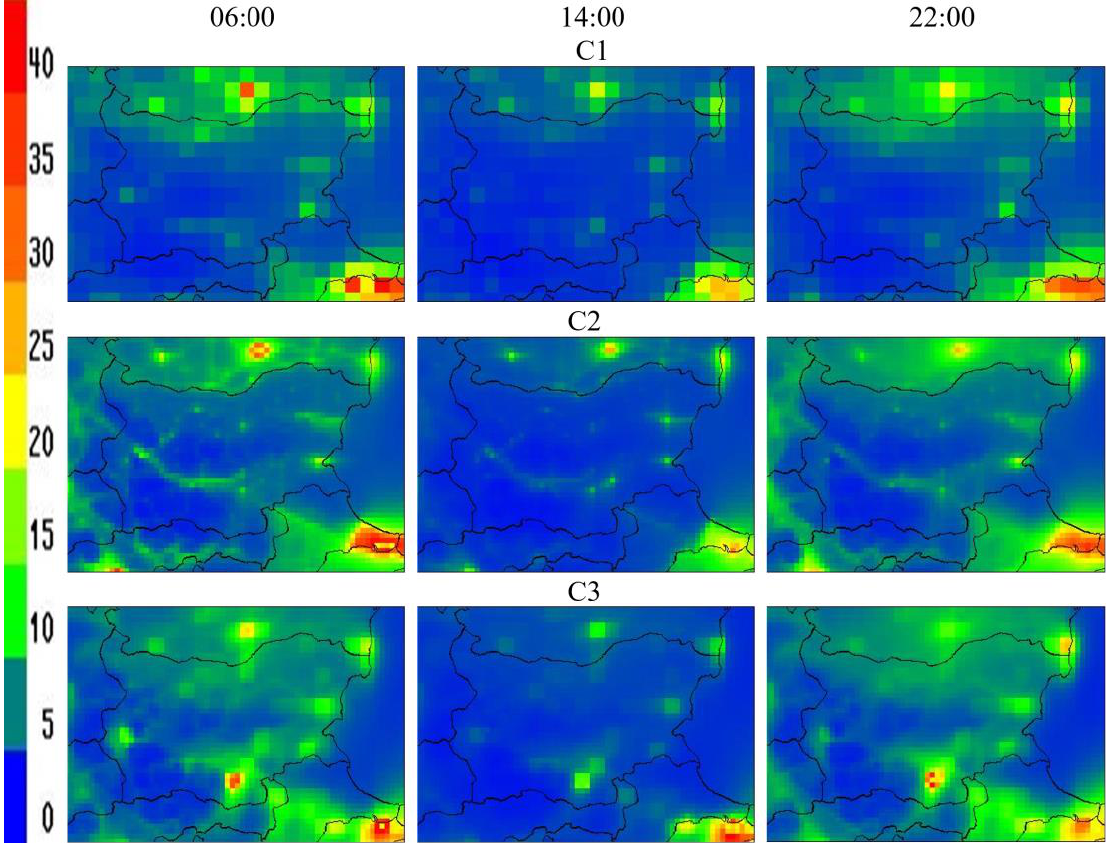
Figure 2. Annually averaged surface concentrations of NO 2 [µg/m 3 ] for cases C1, C2 and C3.